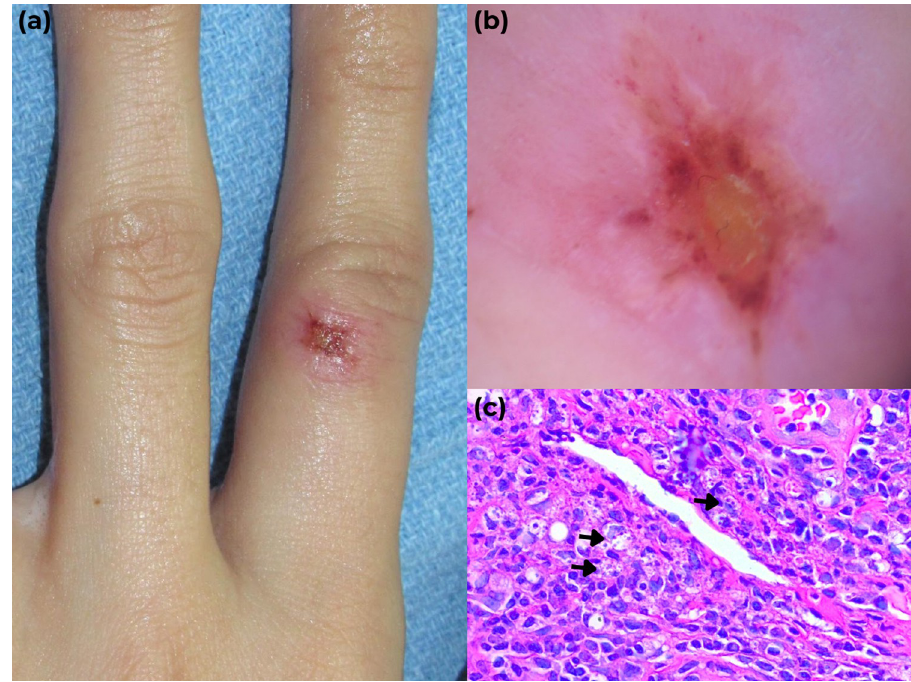
Fig 1. (a) Erythematous papule with central ulceration on the proximal phalanx of the left index finger, at the puncture site before treatment. (b) Dermoscopy shows erythema with a yellowish hue, central ulceration, peripheral white lines, and dotted vascular structures. (c) Histologic findings evidenced a dermal lymphohistiocytic infiltrate with amastigote organisms within histiocytes (hematoxylin & eosin; original magnification × 40).